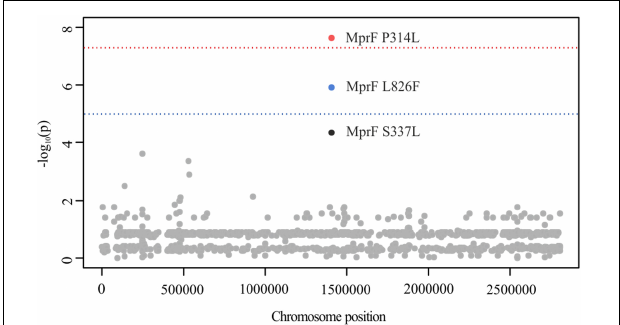
FIGURE 1 | Manhattan plot illustrating DAP PLINK results. The -log 10 unadjusted p -values of identified SNPs are plotted against the entire length of the chromosome of S. aureus COL. The blue line indicates suggestive association ( p = 1 × 10 − 5 ), while the red line indicates the genome-wide significance threshold ( p = 5 × 10 − 8 ). For illustration purposes, SNPs with a -log 10 p -value of 0 have been excluded ( n =